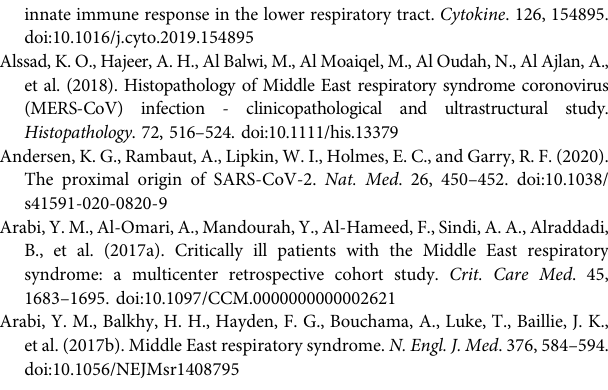
Frontiers in Pharmacology |